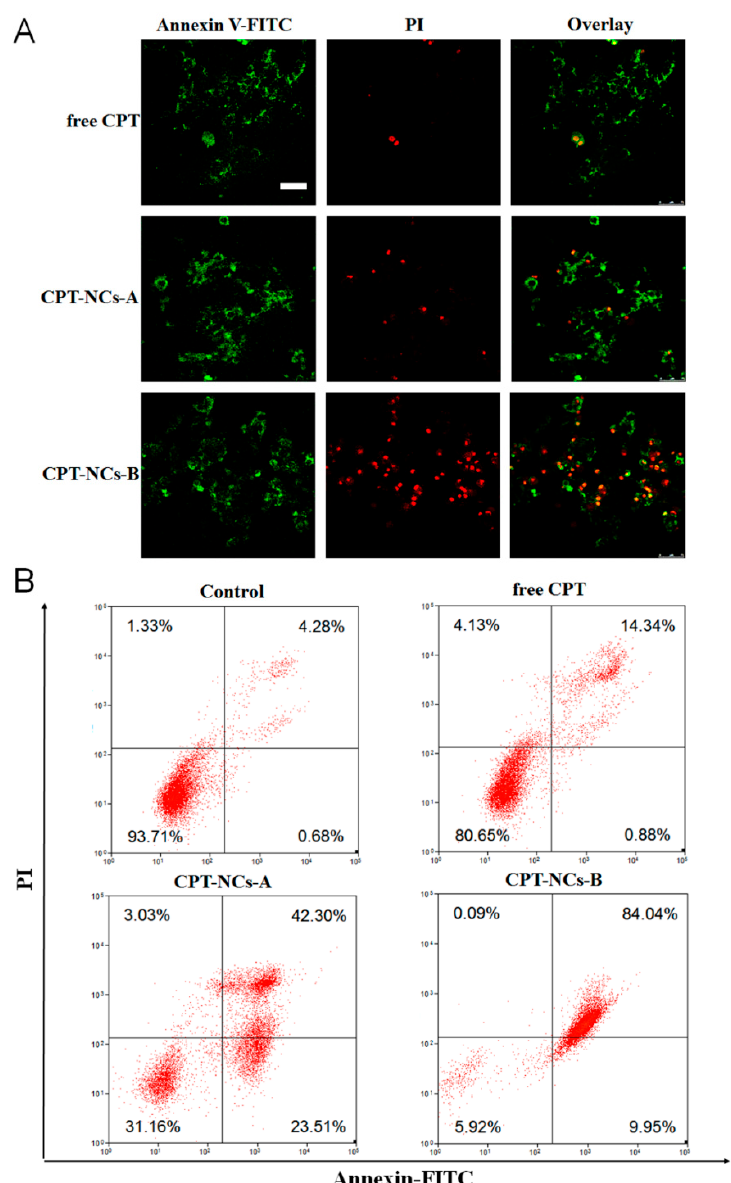
Figure 7. ( A ) CLSM of Annexin V-fluorescein isothiocyanate isomer (FITC)/propidium iodide (PI) double staining (green = early apoptotic cells, red = late apoptotic cells) of SCC-15 cells after treatment with free CPT, CPT-NCs-A, and CPT-NCs-B. Scale bar = 75 µ m; ( B ) Flow cytometry (FCM) analysis of Annexin V-FITC/PI double staining of SCC-15 cells after treatment with PBS, free CPT, CPT-NCs-A, and CPT-NCs-B.